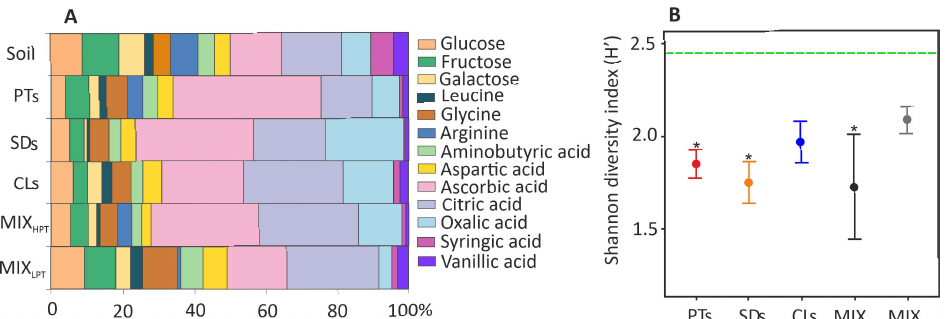
Figure 3. Community level physiological profile ( A ) expressed by contribution of respiration on addition of individual substrates to total substrate-induced respiration in the natural soil and soil-like materials. The Shannon diversity index ( B ) presents as mean (circles) are standard error (bars) for materials, dotted line represents the mean for the soil. Means with * indicate significantly differences from the natural soil (Dunnett’s